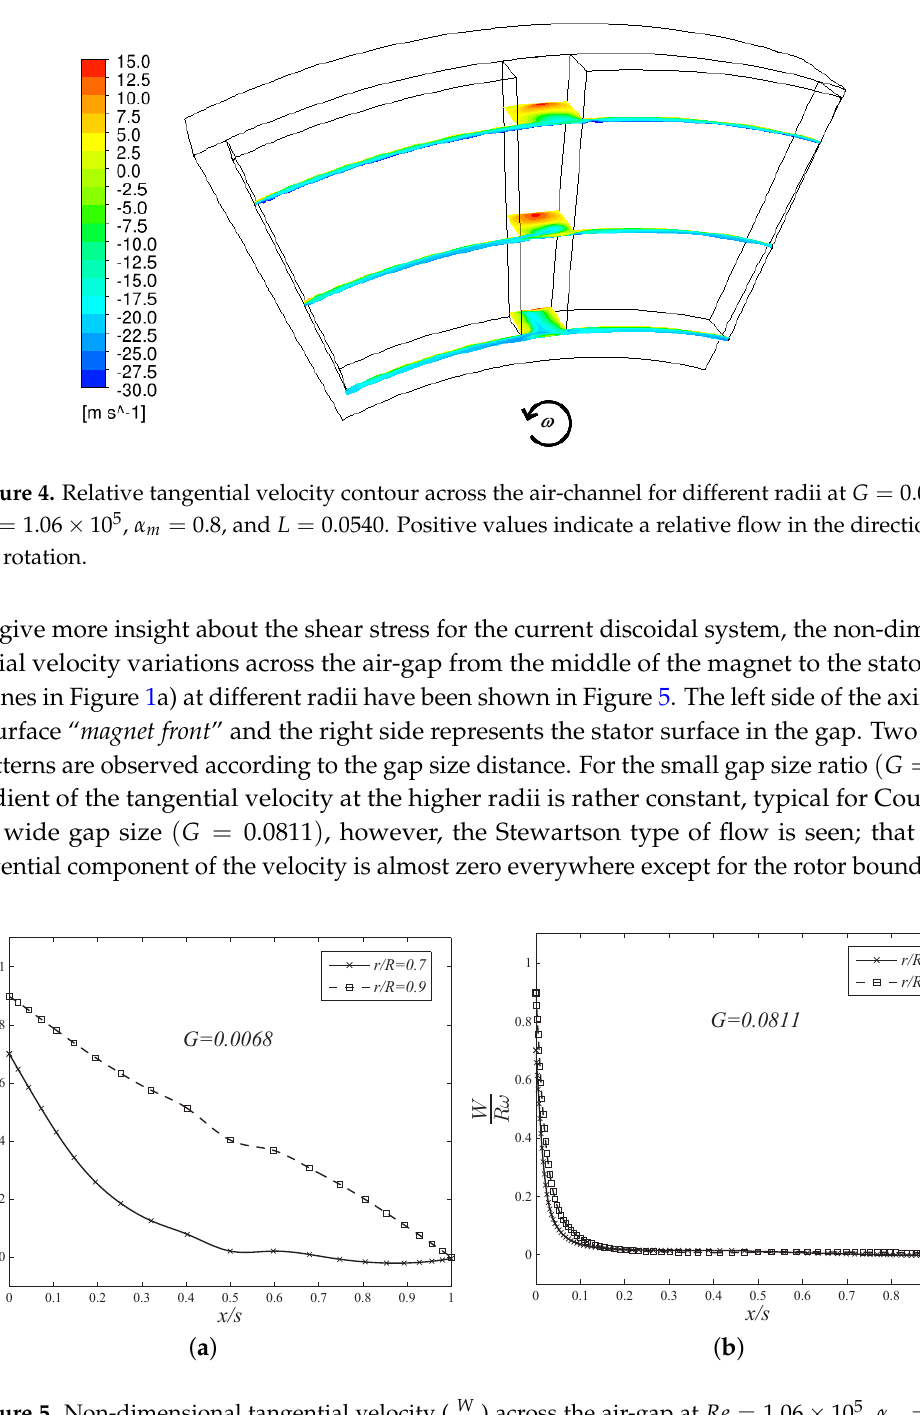
Figure 5. Non-dimensional tangential velocity ( W ) across the air-gap at Re = 1.06 × 10 5 , α m = 0.8 R ω and L = 0.0540 for ( a ) G = 0.0068 and ( b ) G = 0.0811. The left side of the axis belongs to the surface “ magnet front ” and the right side represents the stator surface in the